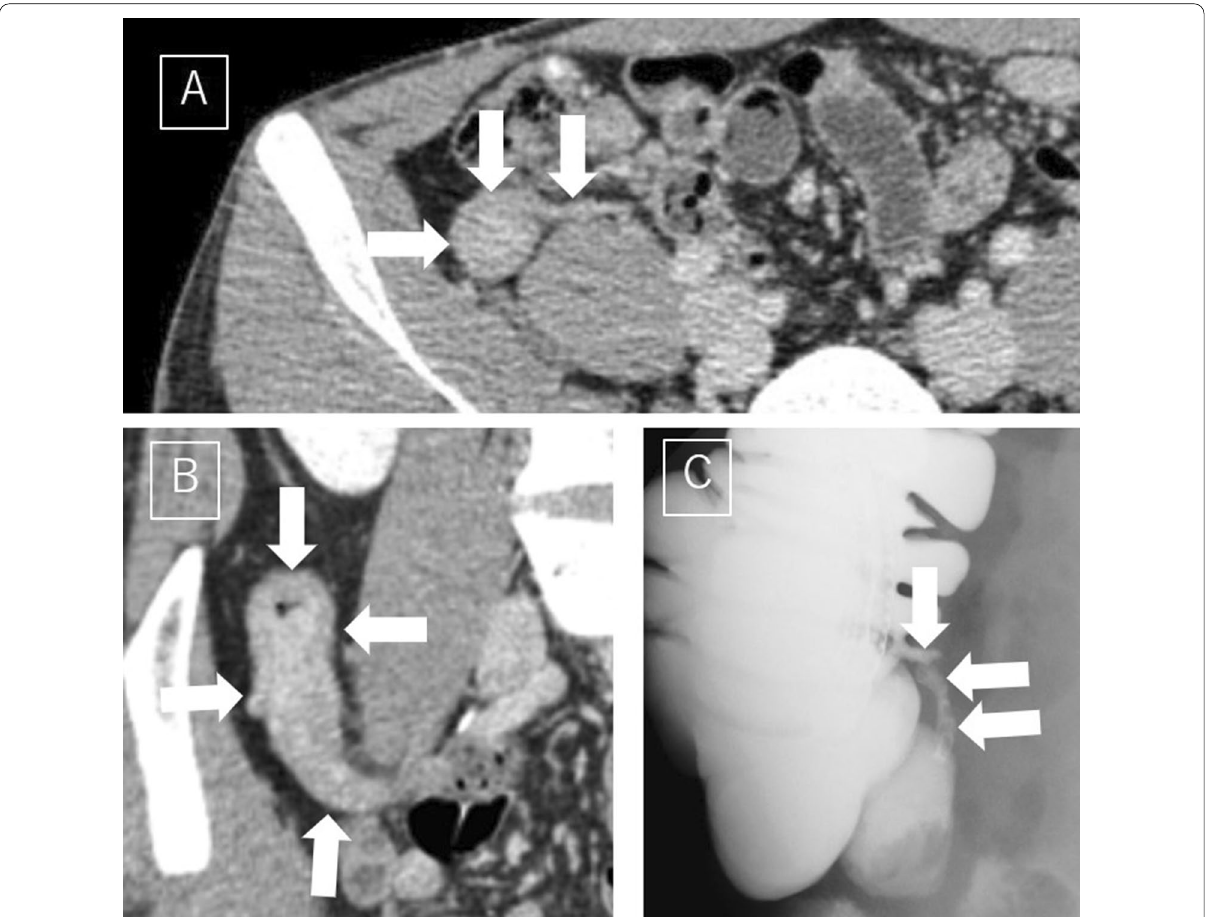
Fig. 1 A , B Enhanced CT revealed an enlarged and diffusely thickened appendix (arrows) on the dorsal side of the ascending colon. The